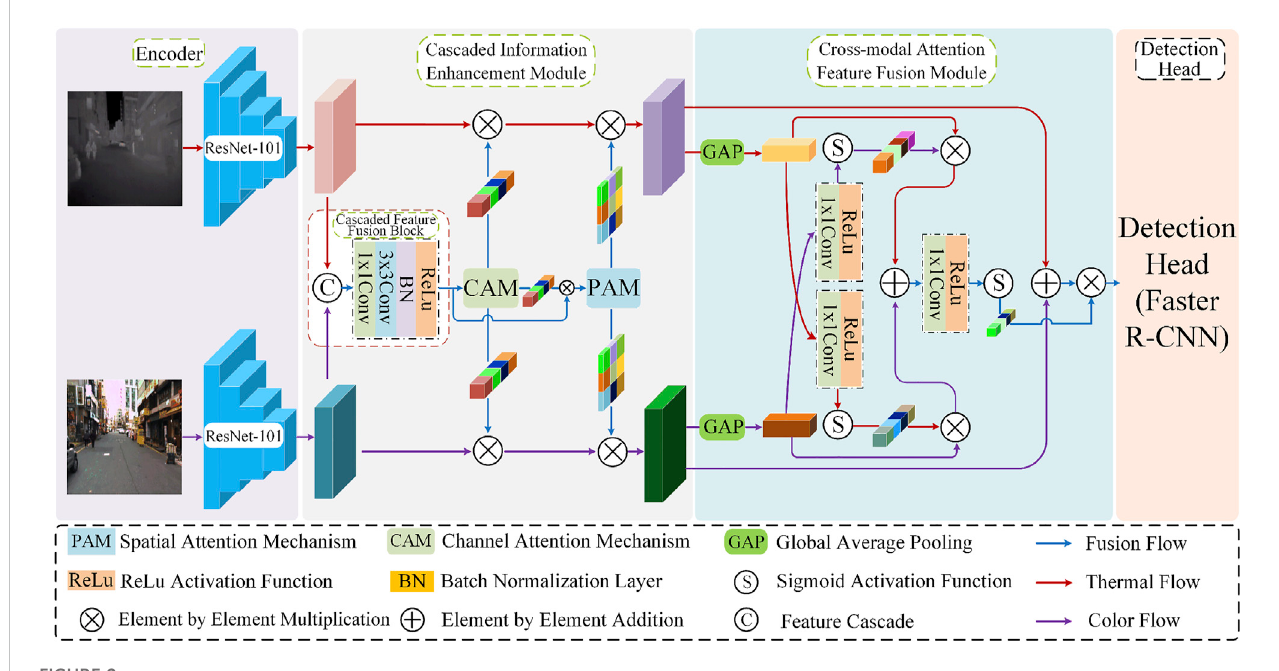
FIGURE 2 Overall framework of the proposed